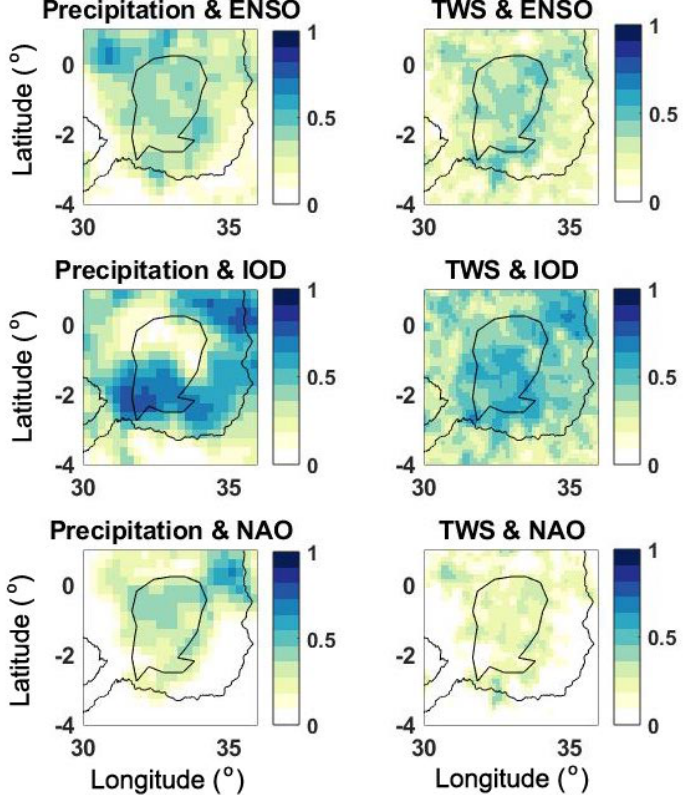
Figure 11. Correlation maps calculated between three climate indicators (top: ENSO, middle: IOD, bottom: NAO) and precipitation ( left ) as well as TWS ( right ).